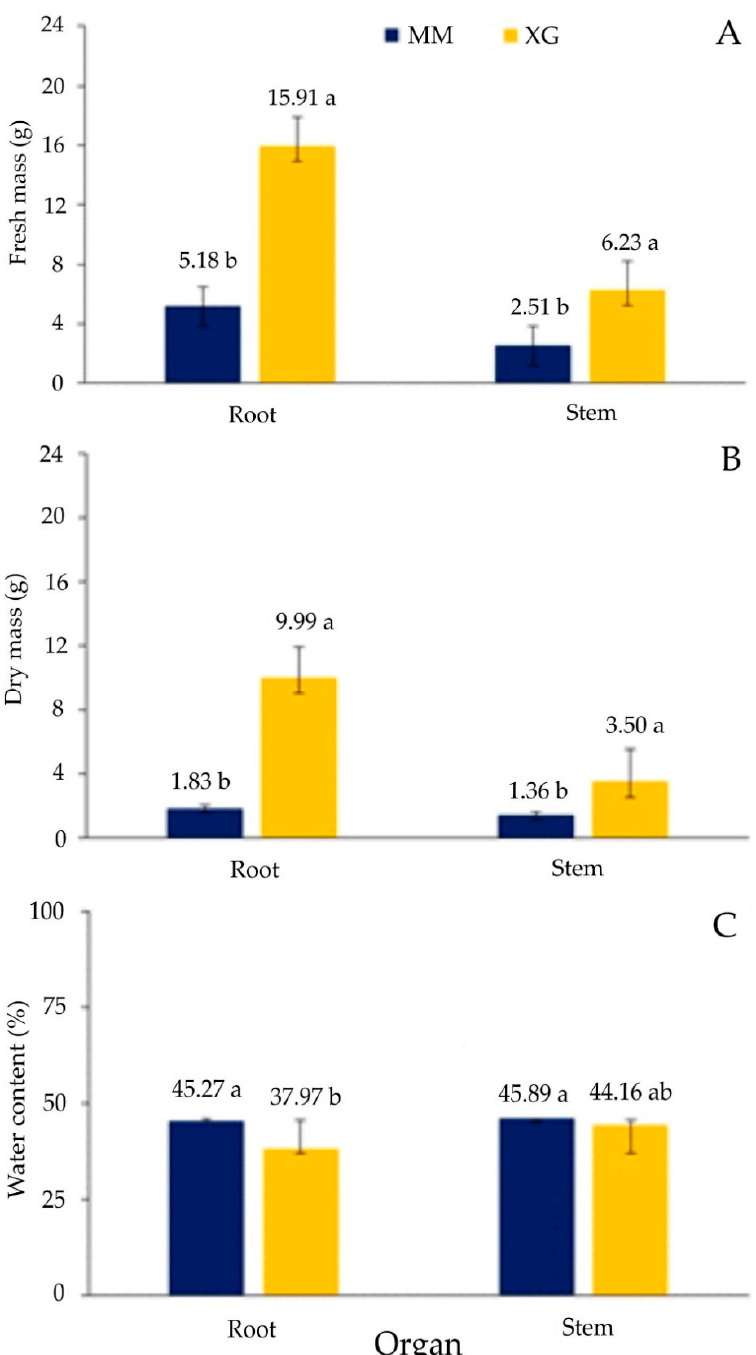
Figure 6. Values of fresh ( A ) and dry mass ( B ) and water content ( C ), organs of Filipendula vulgaris Moench plants taken from the areas of Molinia meadows (MM) and xerothermic grasslands (XG); mean values (± SD) marked with different letters a, b differ significantly according to Tukey’s test (for different N) at p <0.05.